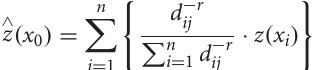
Figure S1 . Figure 2 shows discretization grid,